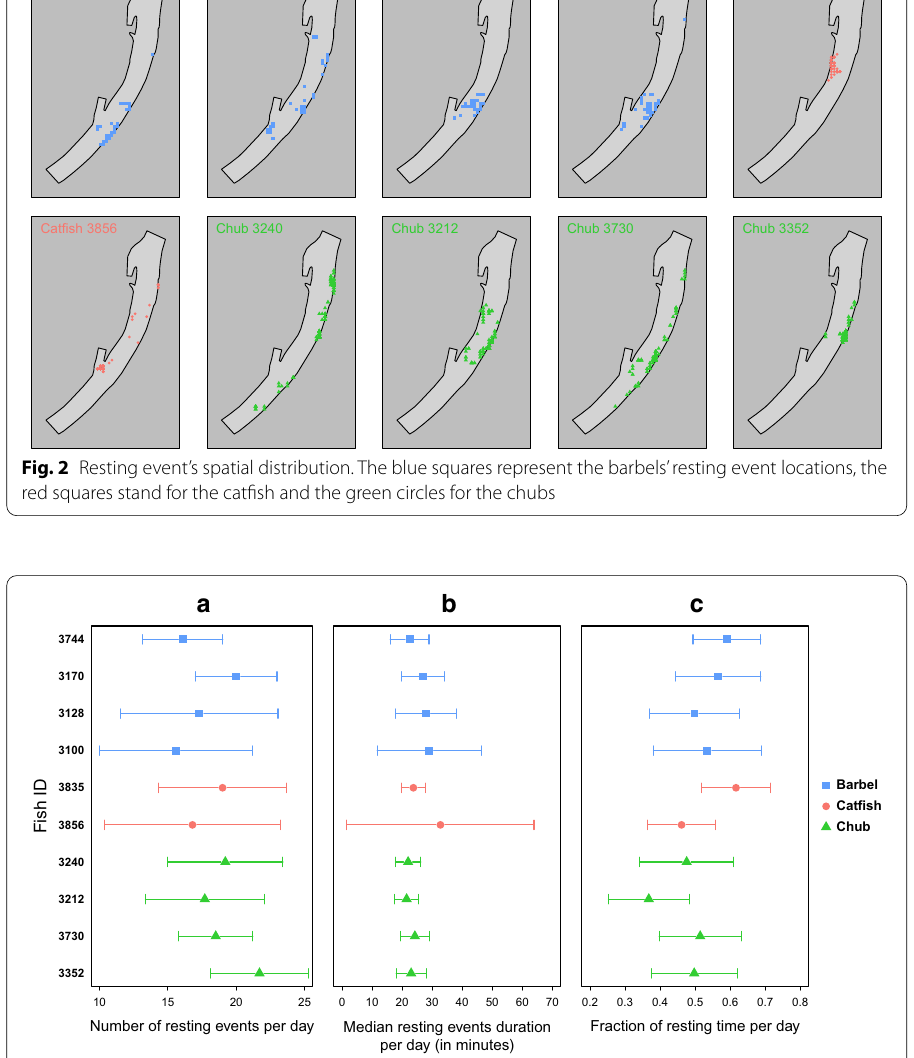
Fig. 3 Characteristics of the resting events according to the fish and species. a Average number of resting events per day. b Average event median duration per day in minutes. c Fraction of resting time per day. The values have been averaged over the 10 days of observation for each fish. The error bars represent one standard